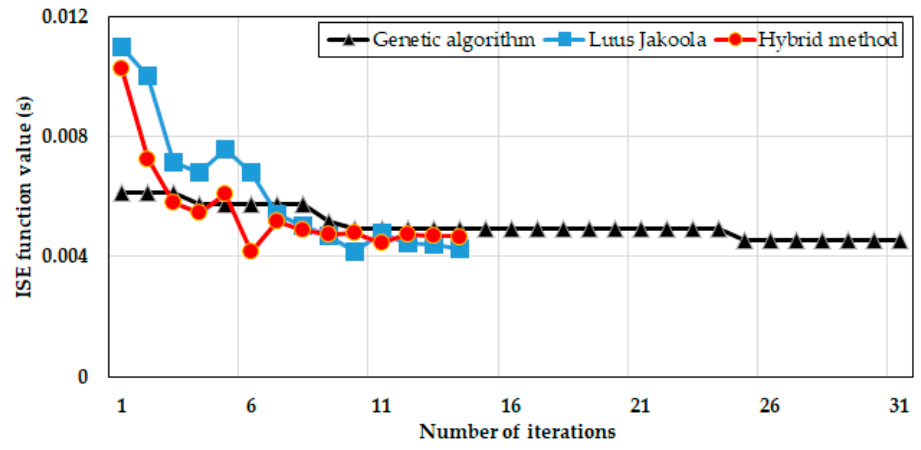
Figure 14. Tuning methods comparison for single source driving.